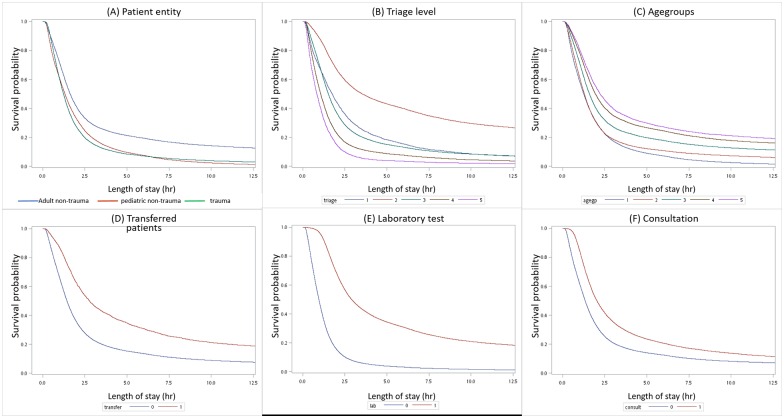
Divided Kaplain-Meier plots.The plots were divided by (a) patient entity, (b) triage level (TTAS), (c) agegroup, (d) transferal, (e) laboratory test, and (f) consultation. All showed statistical difference between stratum.